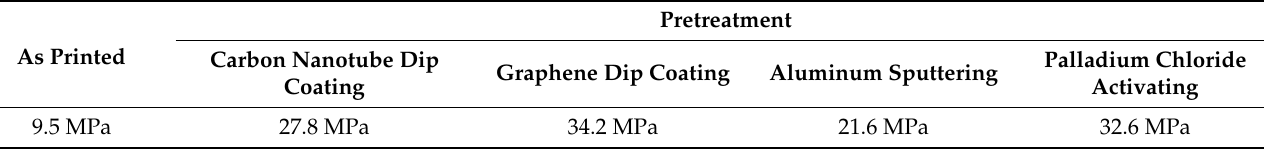
Table 5. Compressive stiffness after electroless nickel plating using different pretreatments.